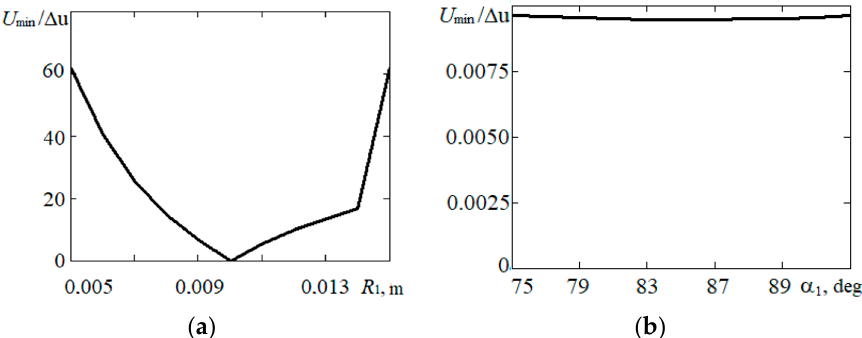
Figure 4. Variation of the reduction of the ratio of quantization counts of an optoelectronic device and an electronic ADC: ( a )—in R 1 , variation α 1 = 85 ◦ ; ( b )—in α 1 variation, R 1 = 0.01